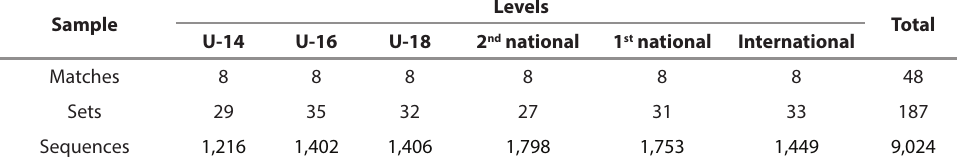
TABLE 1. Distribution of the sample for the different age groups and levels of competition (women’s volleyball) Sample